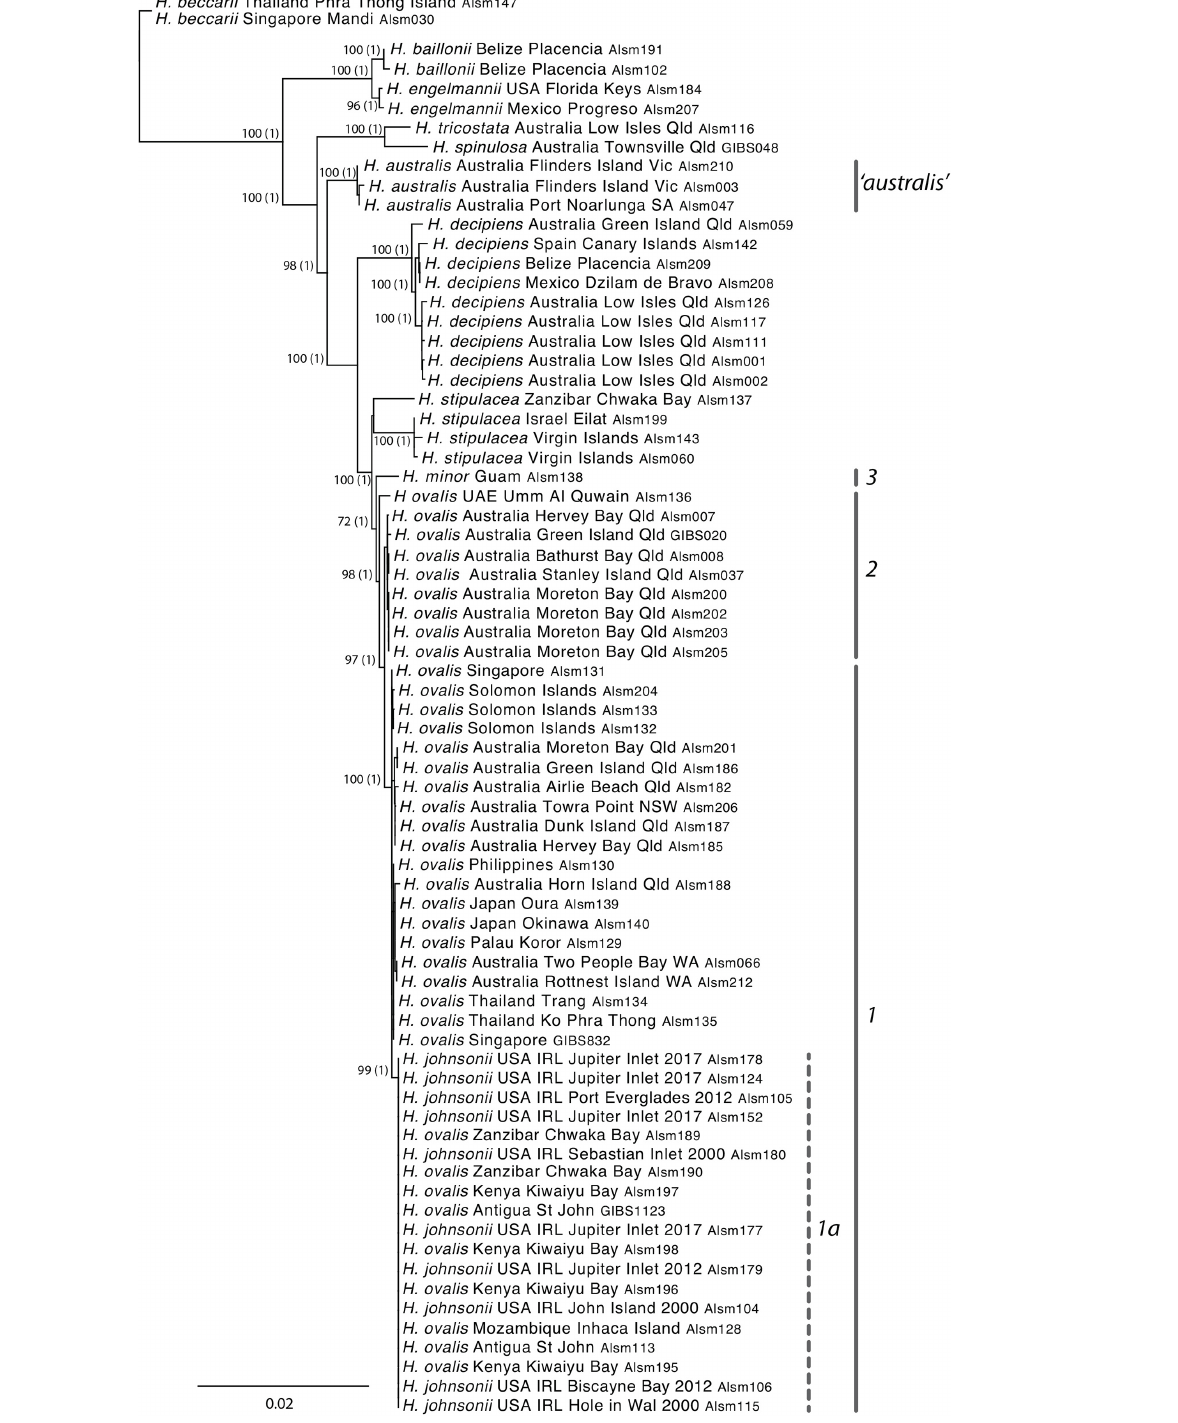
FIGURE 2 | Maximum-likelihood topology obtained from the 16 locus hybridization capture generated plastid (cp) DNA regions for 73 samples of Halophila using RAxML and the GTR Gamma I nucleotide substitution model and 500 bootstrap replicates. ML support values ≥ 50%, and PP > 0.8 (Bayesian analyses, bracketed) are shown adjacent to the node. Unlabeled nodes had support values lower than this value. Highlighted groups include: 1 –Clade III of Uchimura et al. (2008) referred to as H. ovalis group; 1a –including H. johnsonii , along with specimens of H. ovalis from the East coast of Africa, and samples from Antigua; 2 – equivalent to clade II of Uchimura et al. (2008) referred to as H. major group; and 3 –single specimen likely to be representative of clade IV following Uchimura et al. (2008); “australis” – true Halophila australis only found in southern temperate Australia; A–broader H. ovalis group ( sensu lato ) used in other analyses.